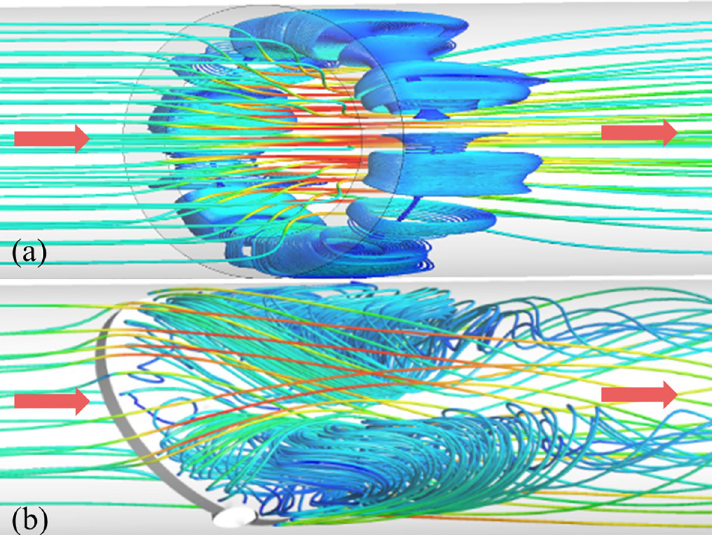
Fig 14. Streamlines distribution in the pipe. (a) Air-ring flow regulating valve. (b) Center butterfly valve.